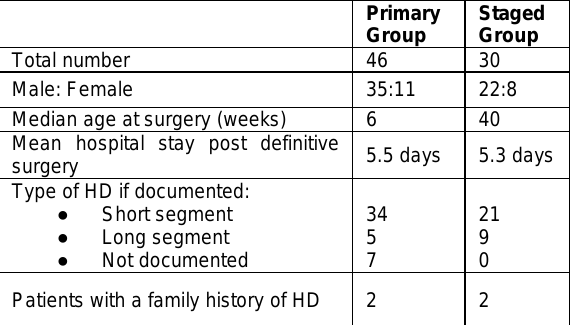
Table 1: Comparison between the Primary and Staged Group